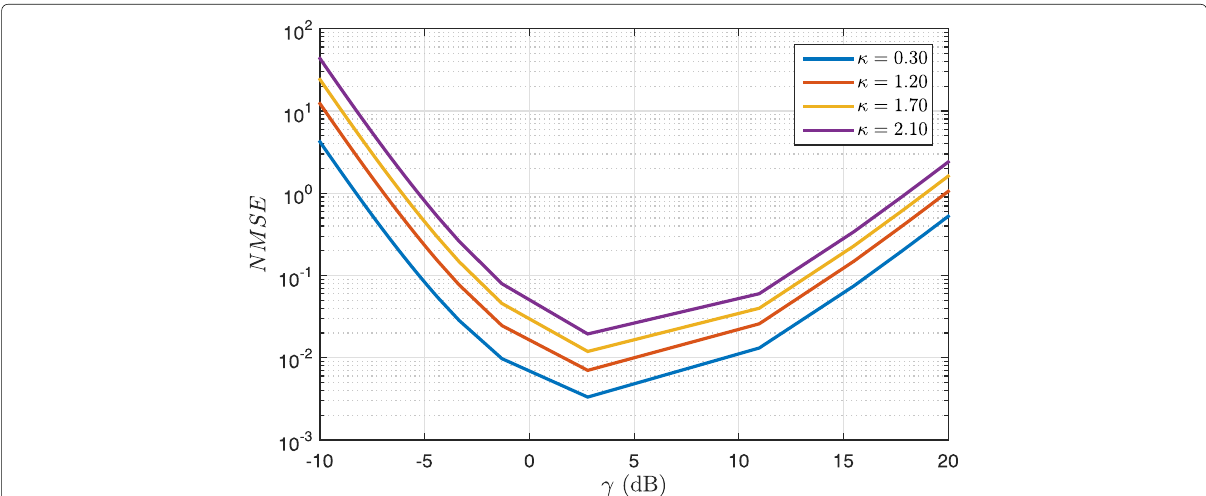
Fig. 7 NMSE of the estimate ˆ γ as a function of SNR in dB for fading κ − μ for N = 5 × 10 4 and 64-QAM modulation considering different values of κ and μ =